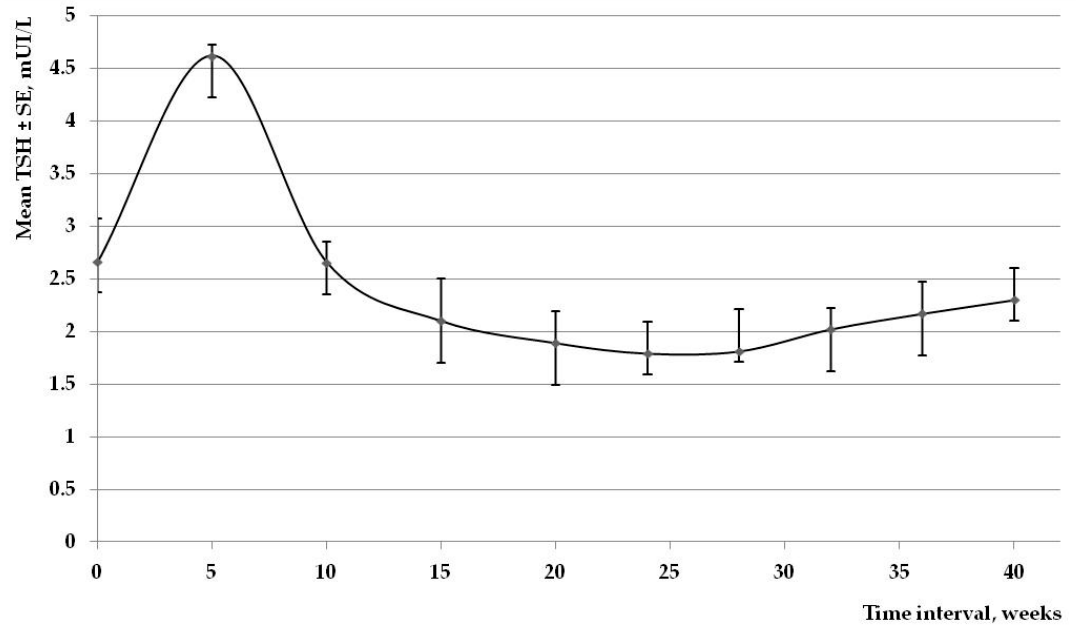
Figure 1. Mean TSH value during the pregnancies in the study group.